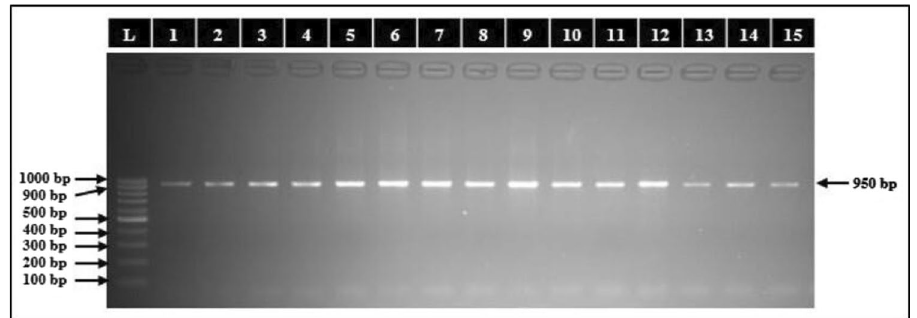
Figure 8. Agarose gel electrophoretic band of 1 kb ladder (Lane L) and PCR purified bands of isolates total genomic DNA extracts with size of 950 bp (Lane 1 to 5).